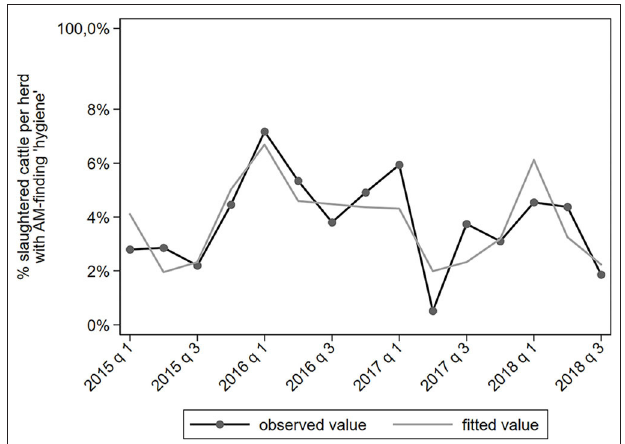
FIGURE 2 | Observed and predicted percentage of slaughtered cattle per dairy herd with a AM-finding categorized under “hygiene,” per quarter between January 2015 to September 2018 ( N = 78,366).